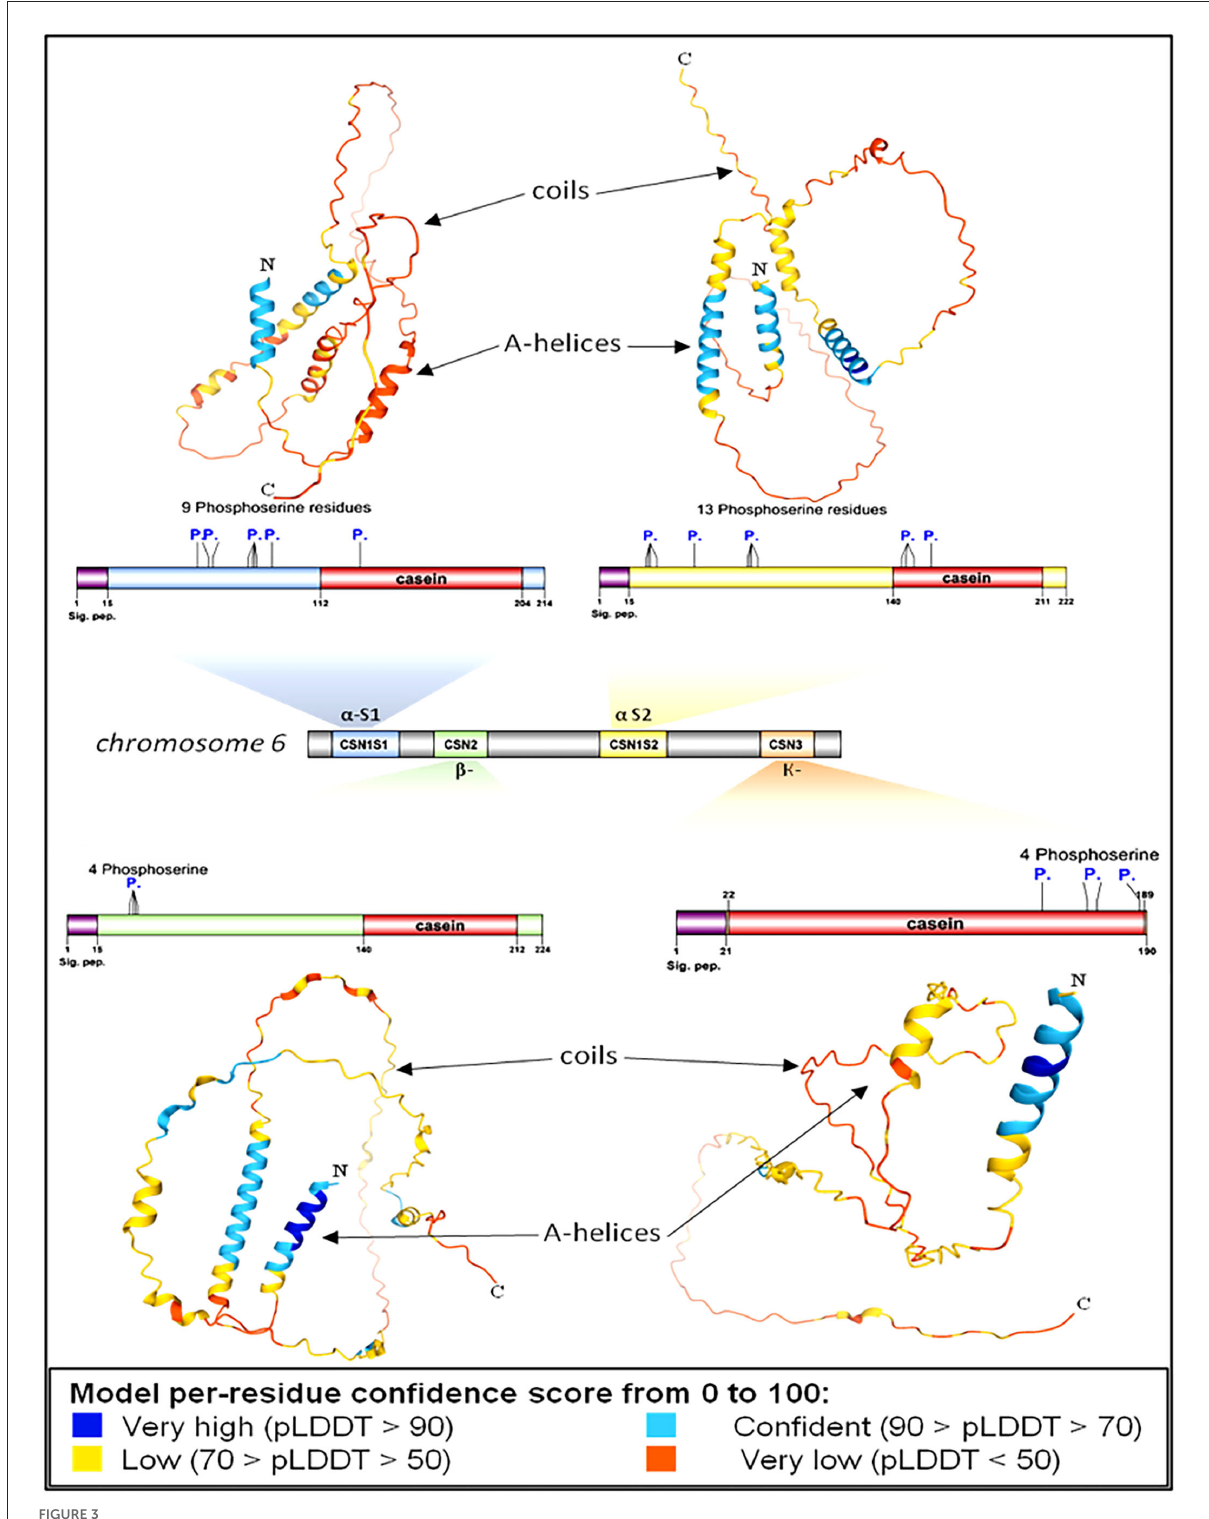
FIGURE3 Genomic and structural characterization of milk caseins from Bos taurus (cattle). Casein subunit organization within chromosome number 6 (middle panel). The characteristics and genetic features of each casein subunit are detailed. Signal peptide domains (sig. pep.) and phosphorylation sites (P.) are indicated on each protein diagram. Ribbon diagrams illustrating the high-resolution structures of alpha-S1-, alpha-S2-, beta-, and kappa-casein. Proteins’ N- and C-termini are indicated on protein